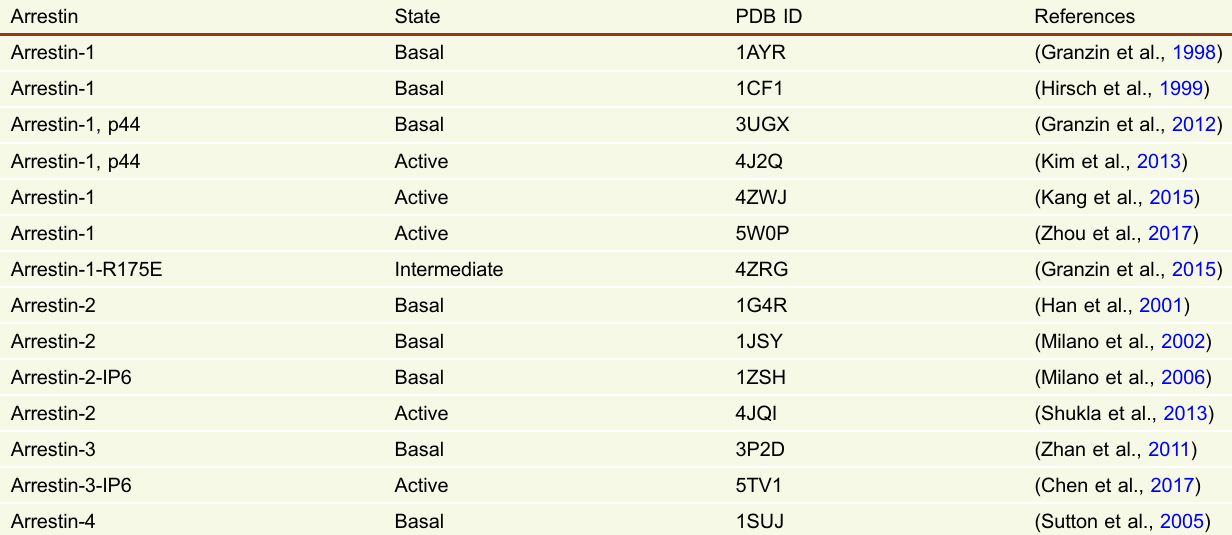
Table 1. Crystal structures of arrestin